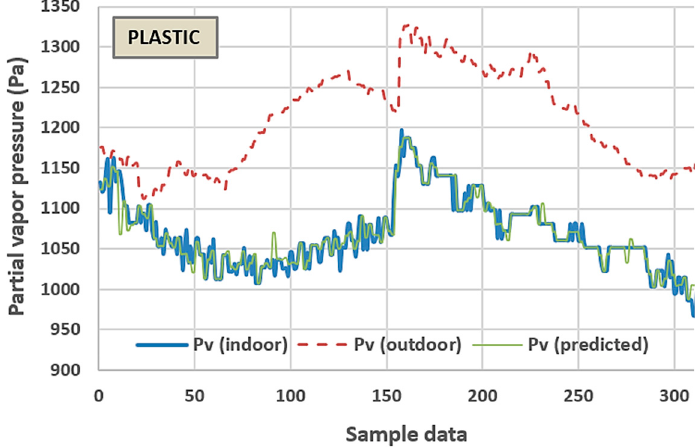
Figure 6. Partial vapour in office buildings with plastic as an internal covering material.